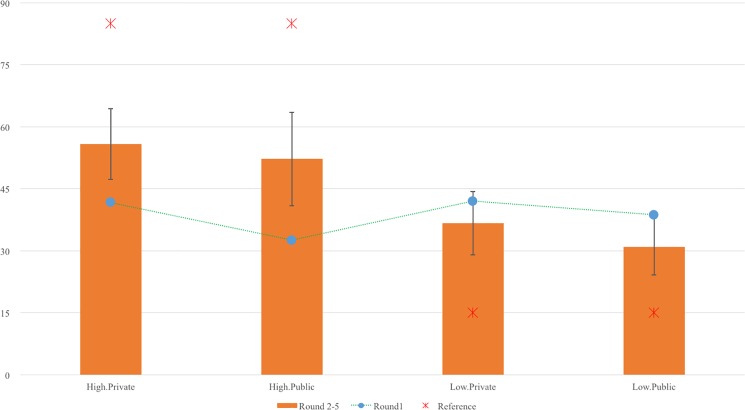
Means of token-sent under 4 conditions comparison of Round 2 through Round 5 with Round 1.